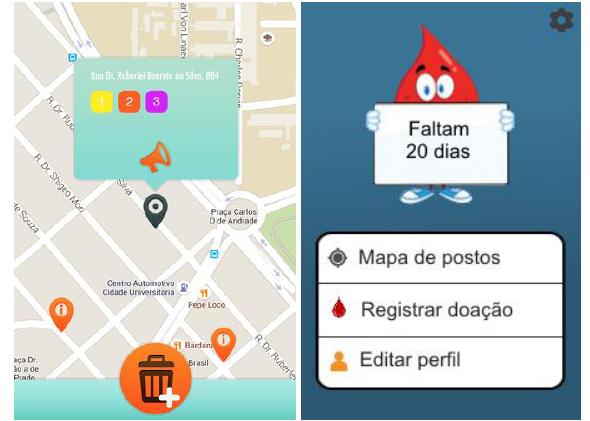
Fig 6. Examples of main screens evaluated in AQ12